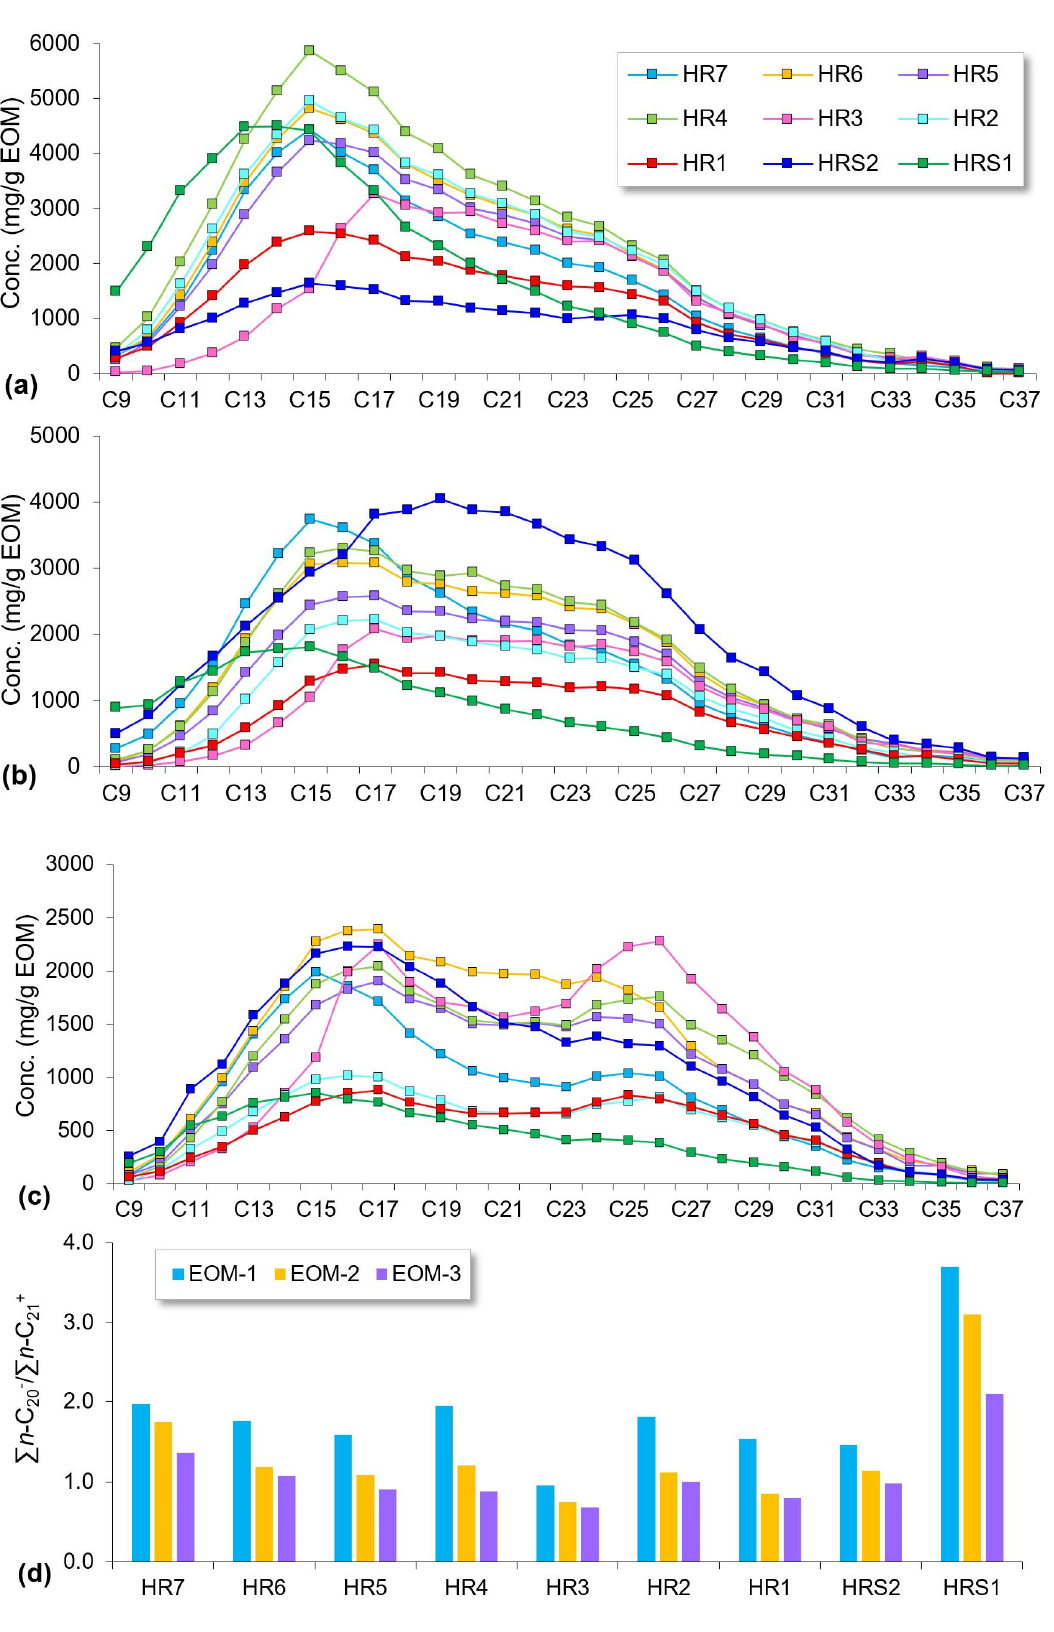
Figure 9. Concentration distributions and ratios of n -alkanes in sequential extracts of the studied samples: ( a ) EOM-1; ( b ) EOM-2; ( c ) EOM-3; ( d ) ∑ C 20 − / ∑ C 21 +